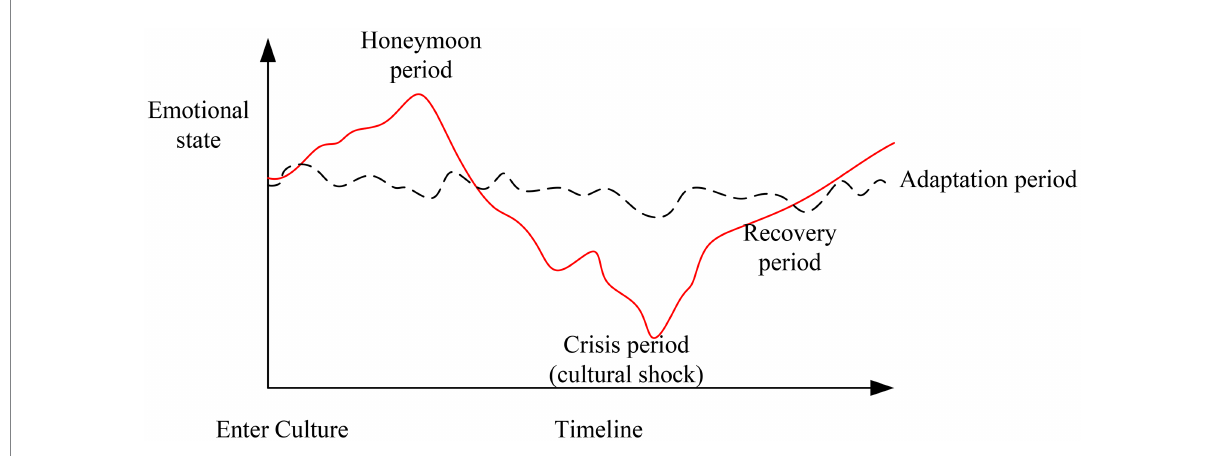
FIGURE 1 U-shaped pattern exhibited by the acculturation